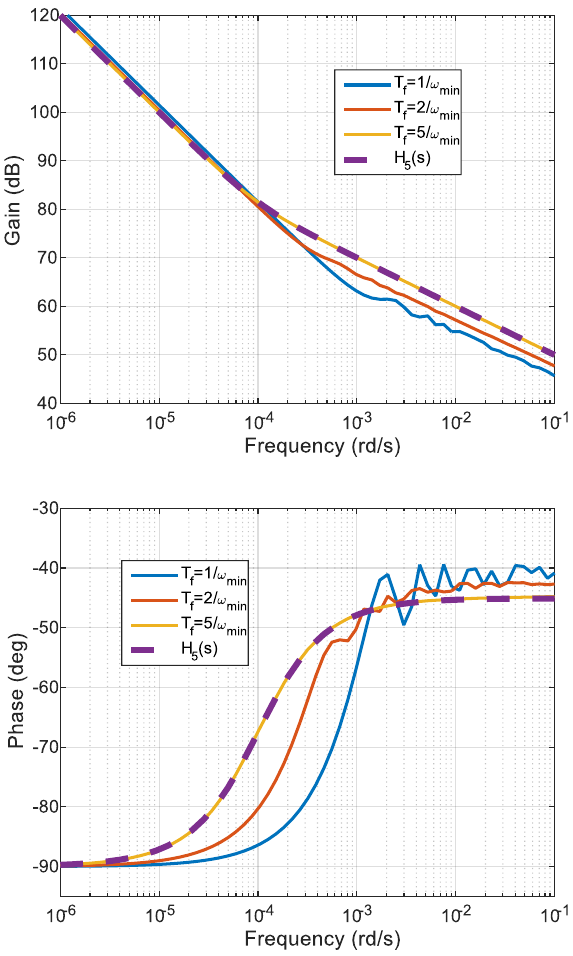
T f ( s ) and of H ( s ) in the domain of interest for ν = 0.5, 5𝑇 𝑓 (𝑠) 5 and of 𝐻 5 (𝑠) in the domain of interest for 𝜈 = 0.5 , 5